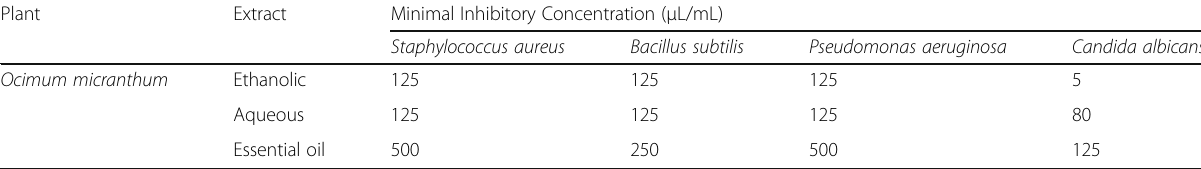
Table 1 Antimicrobial activity of essential oil and extracts of Ocimum micranthum Willd leaves Plant Extract Minimal Inhibitory Concentration ( μ L/mL) Staphylococcus aureus Bacillus subtilis Pseudomonas